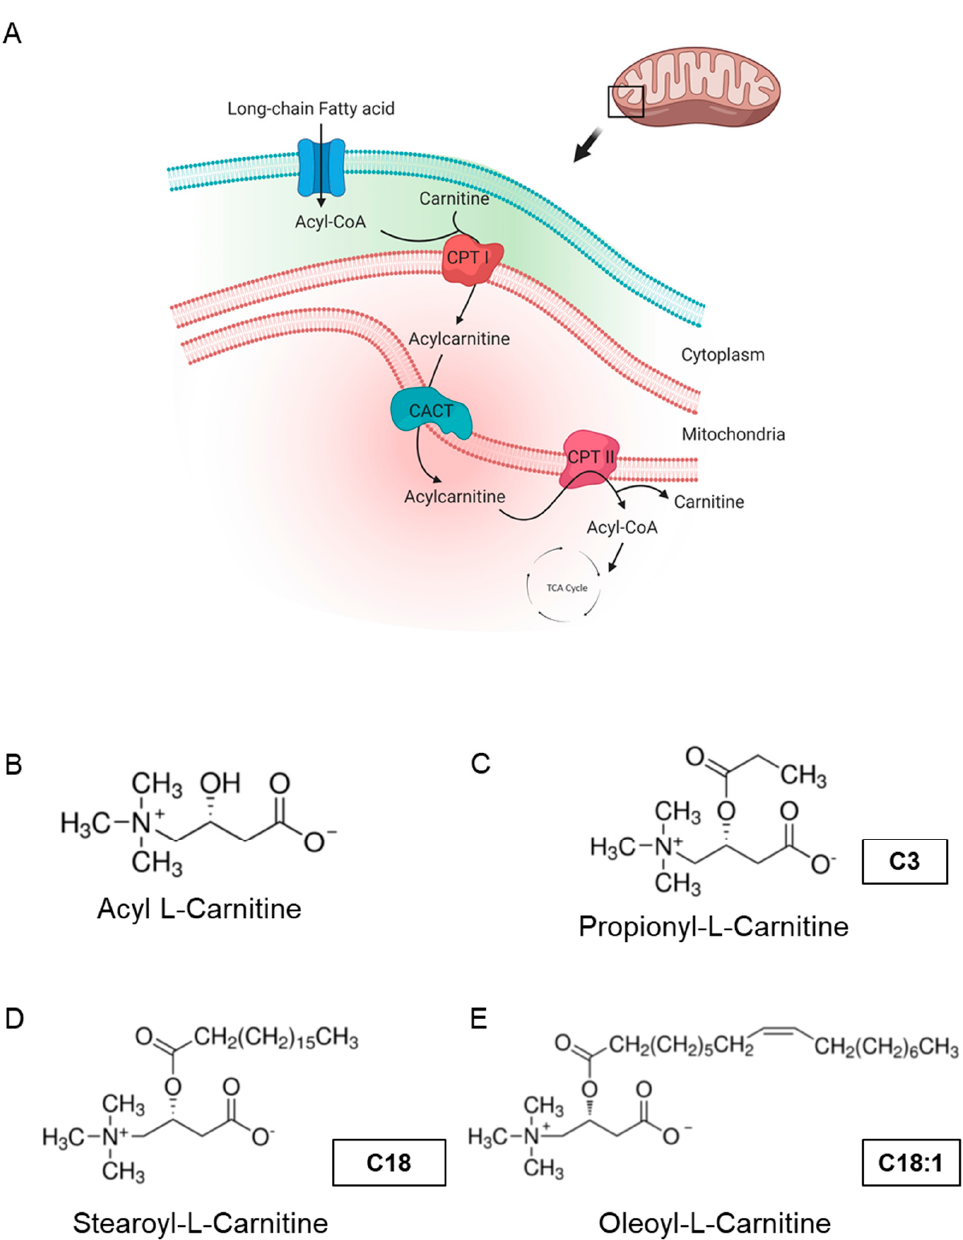
Figure 1. Carnitine shuttle in mitochondria and chemical structures of carnitines. ( A ) Description of acylcarnitine metabolism (free fatty acid metabolism) in general. Acyl-CoA and carnitine are conjugated (acylcarnitine) by carnitine-palmitoyl transferase I (CPT I) and transported across the inner membrane of mitochondria via carnitine-acylcarnitine translocase (CACT). Then, acyl-CoA and carnitine are released into the mitochondrial matrix by carnitine-palmitoyl transferase 2 (CPT II). Acyl-CoA is finally degraded and released as acetyl-CoA to enter the TCA cycle, synthesizing ATP. Subfigure A is created by BioRender.com (accessed on 23 March, 2021). ( B – E ) Molecular structures of acyl- L -carnitine, short-chain carnitine and long-chain acylcarnitines (LCACs). Acyl- L -carnitine (Figure 1B) belongs to the family of carnitines, a group of naturally occurring compounds that are essential for the β -oxidation of FAs in mitochondria during ATP synthesis [4]. Long-chain acylcarnitines (LCACs, e.g., C18 or C18:1) are intermediates in intramitochondrial FA metabolism. For instance, the long-chain acylcarnitine C18:1 is an intermediate transportation form for the monounsaturated FA C18:1 and high LCAC levels have been related to CVD, including heart failure (HF), coronary artery disease (CAD) and cardiac arrhythmias [5–11]. Hence, LCACs are not only potential CVD bi- omarkers, but might also be the putative cause of distinct cardiac disease.